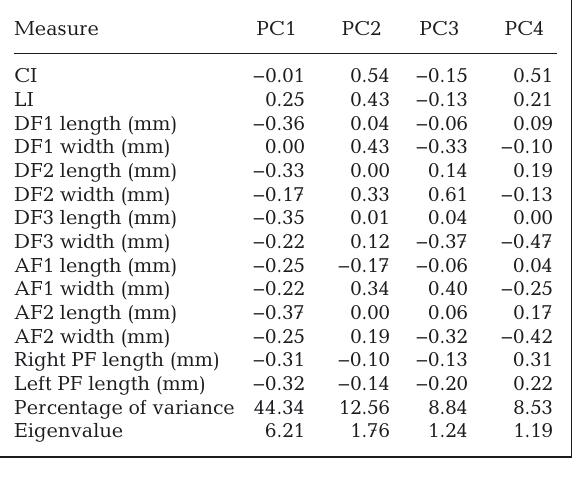
Fig. 3. Individual factor scores for the first 3 principal components (PCs) for traditional morphomet- ric analysis, for farmed (n = 108) (filled black circles) and wild (n = 36) (filled red triangles) Gadus